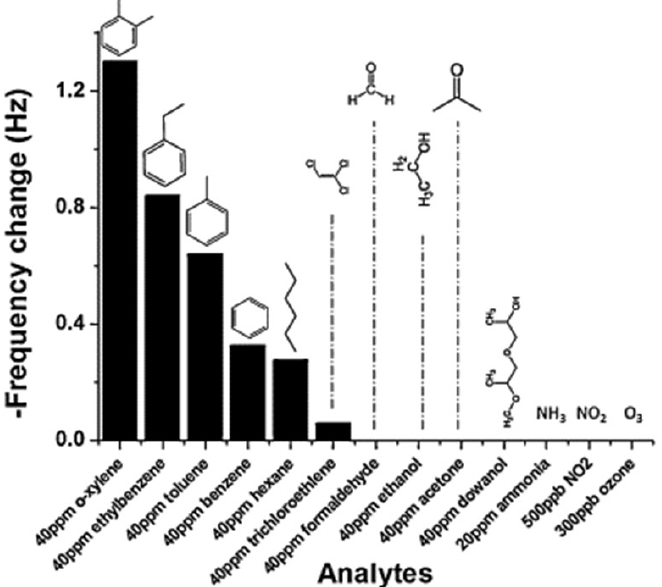
Figure 3. p− Xylene imprinted SAW sensor response to VOCs ( left ) and response from a non−im- printed equivalent ( right ). Both polymers were prepared from polyurethane to give a layer of ap- proximately 40 nm, but only the imprinted polymer used p− xylene as solvent. Reproduced with permission [137].